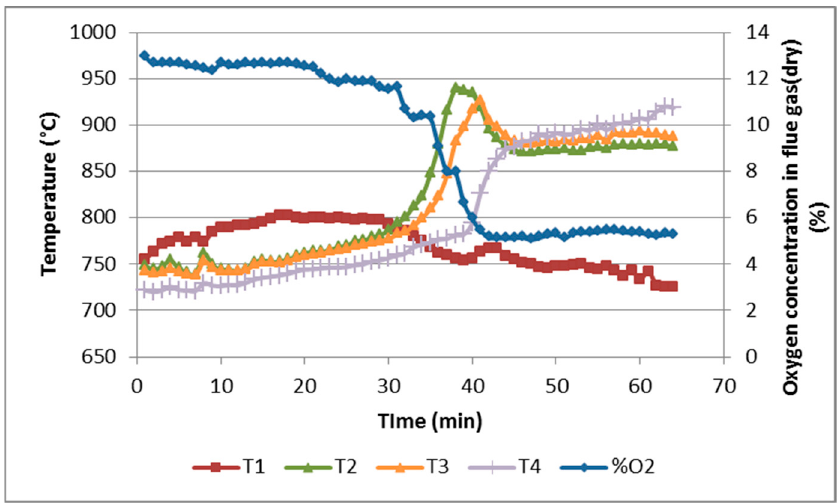
Table 5. Axial distances of individual thermocouples from the burner.